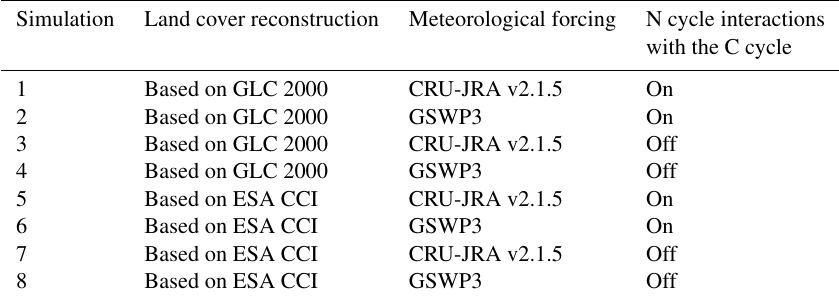
Table 1. Summary of simulations performed with two representations of the historical land cover, two sets of meteorological data, and two versions of the CLASSIC land